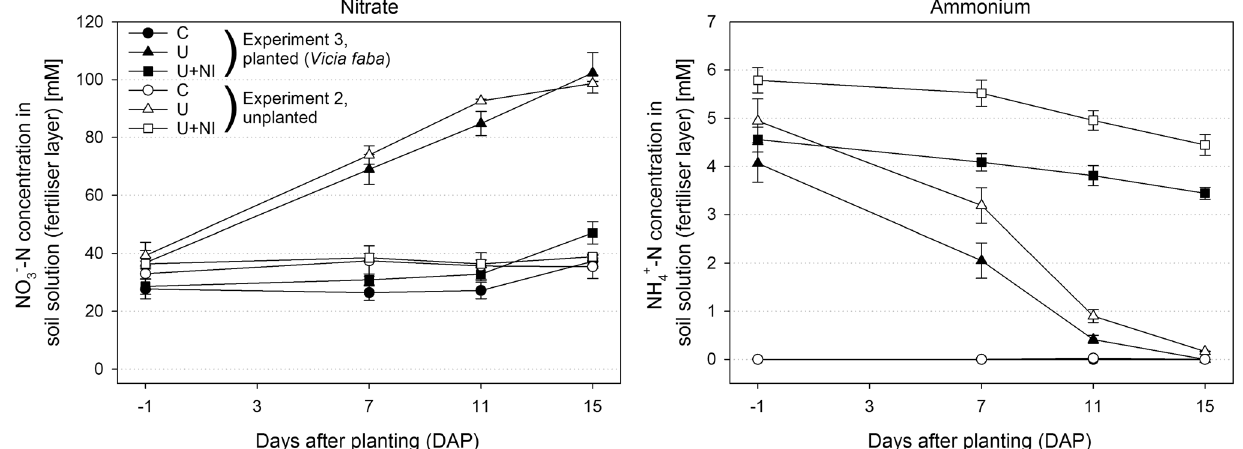
Figure 3. Temporal change of NO 3– -N (left) and NH 4+ -N (right) concentration in soil solution in the